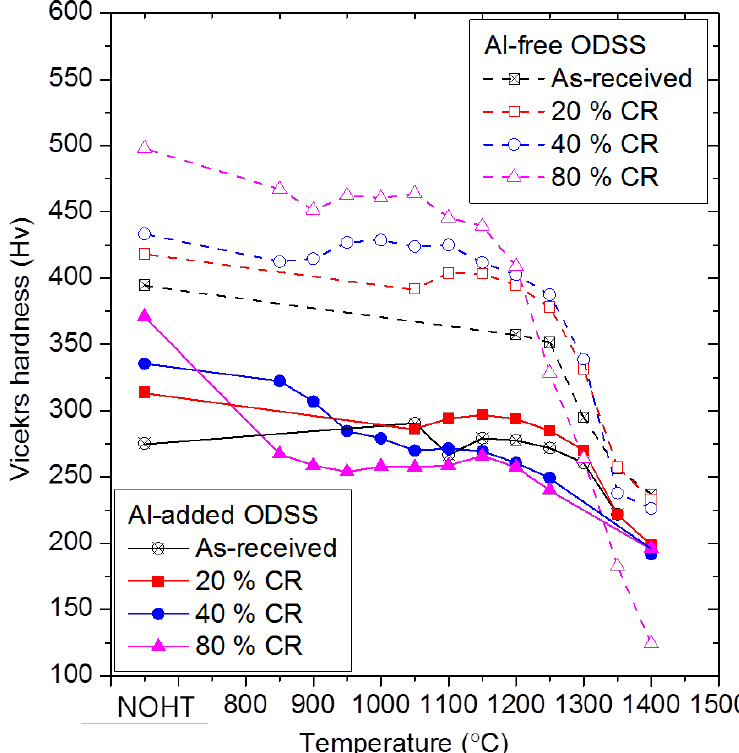
Figure 5. Vickers hardness changes of Al-added and Al-free 15Cr-ODS ferritic steels consolidated by extrusion method after isothermal annealing for 1 h at temperatures from 850 °C to 1400 °C with 50 °C steps. Before the annealing, specimens were cold rolled (CR) with 20%, 40% and 80% reduction of area. NOTH stands for no heat treatment.